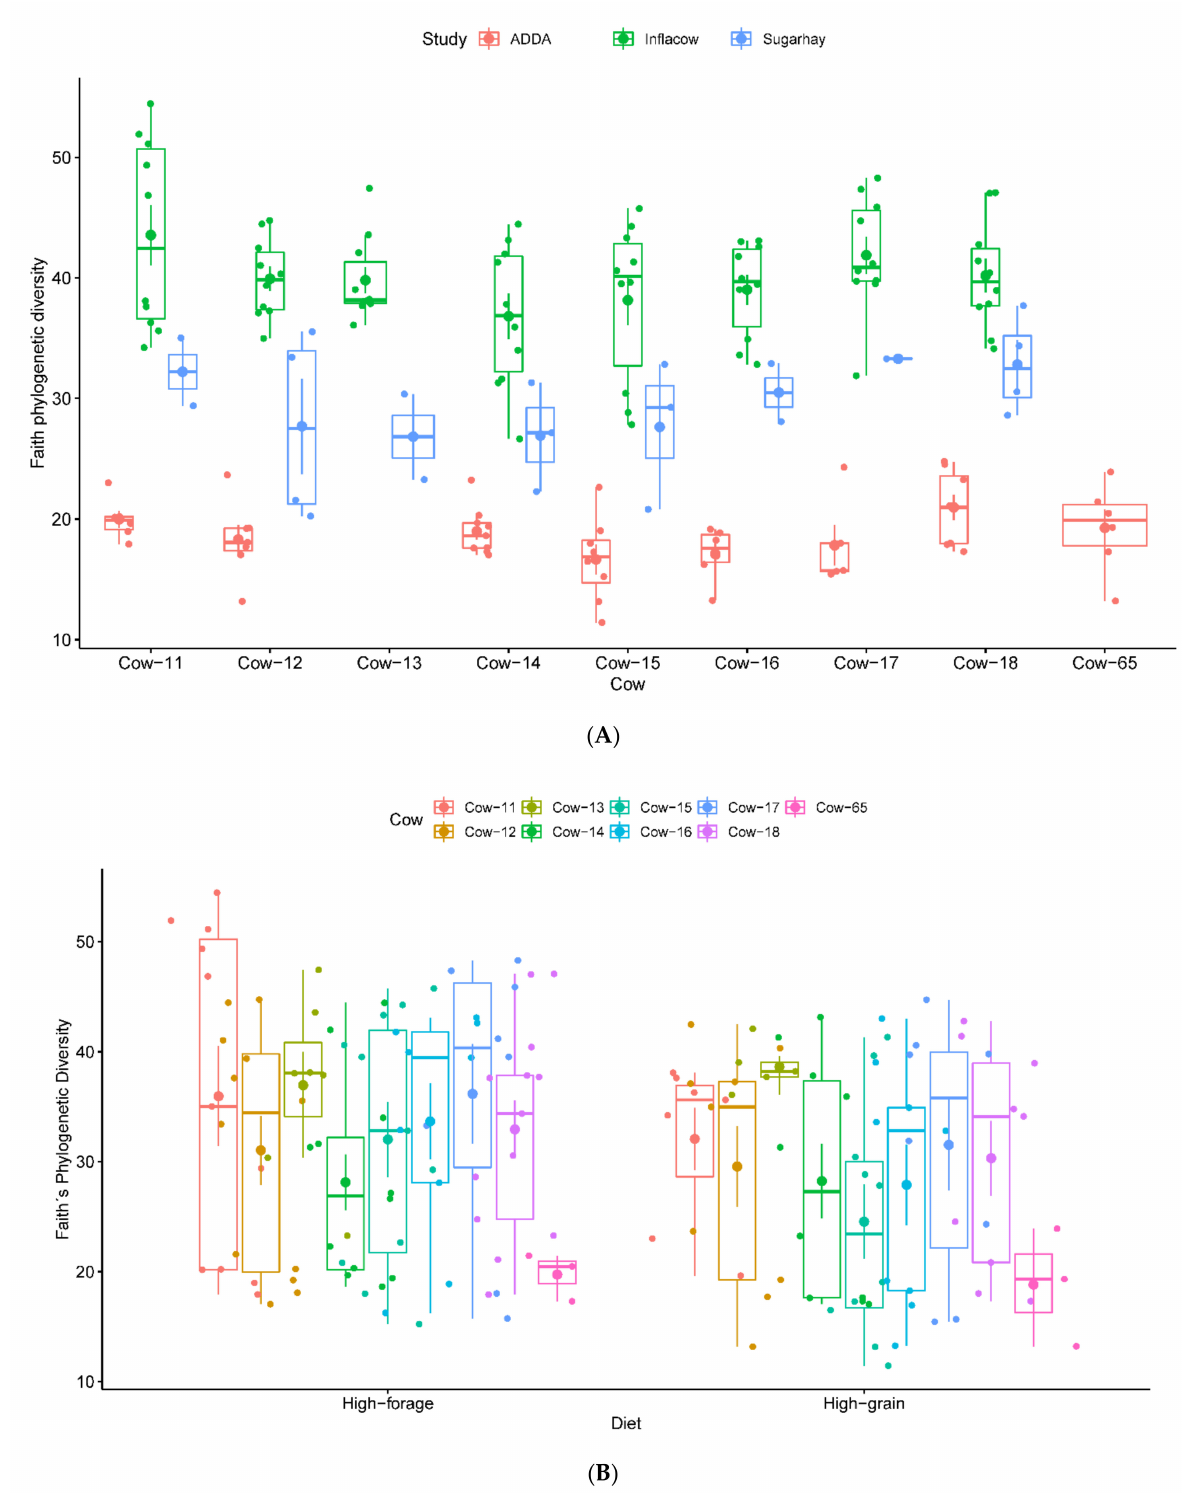
Figure 9. Phylogenetic diversity according to animal variability per each study ( A ) and diet per individual cow ( B